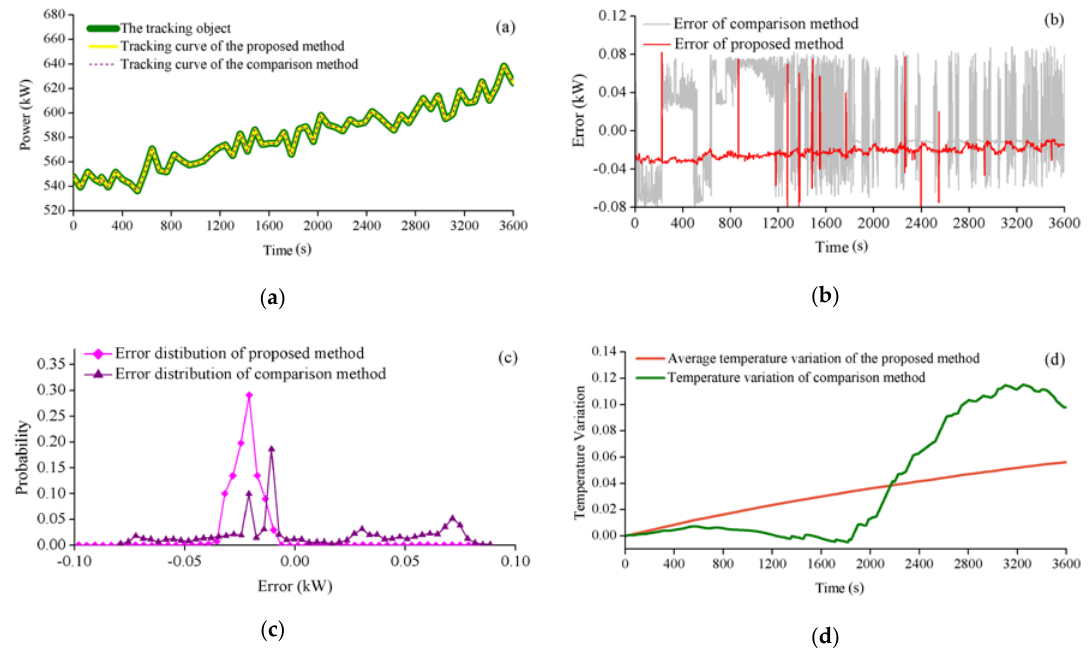
Figure 6. ( a ) Wind power tracking of two methods; ( b ) tracking errors of proposed method and